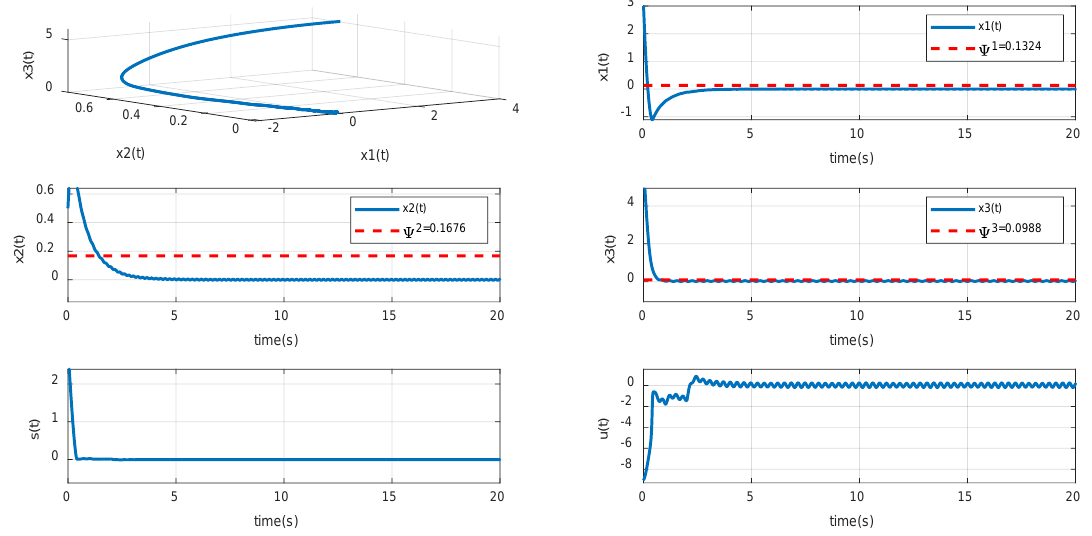
Figure 5. The system dynamics of the controlled Rössler systems with unknown time-varying delays and unmatched uncertainties.